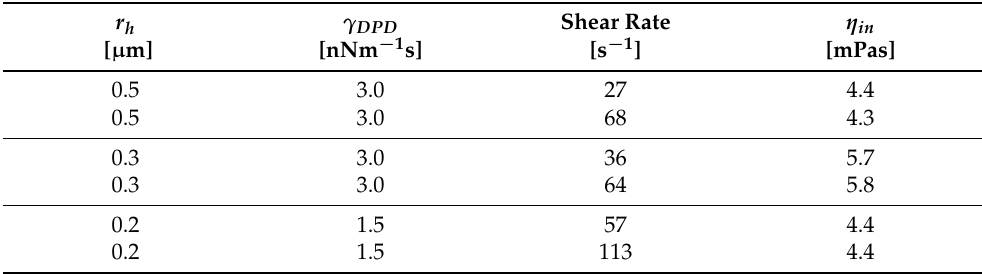
Table 5. At low shear rates, the shear rate has almost no impact on the particle suspension viscosity (here φ = 0.5).